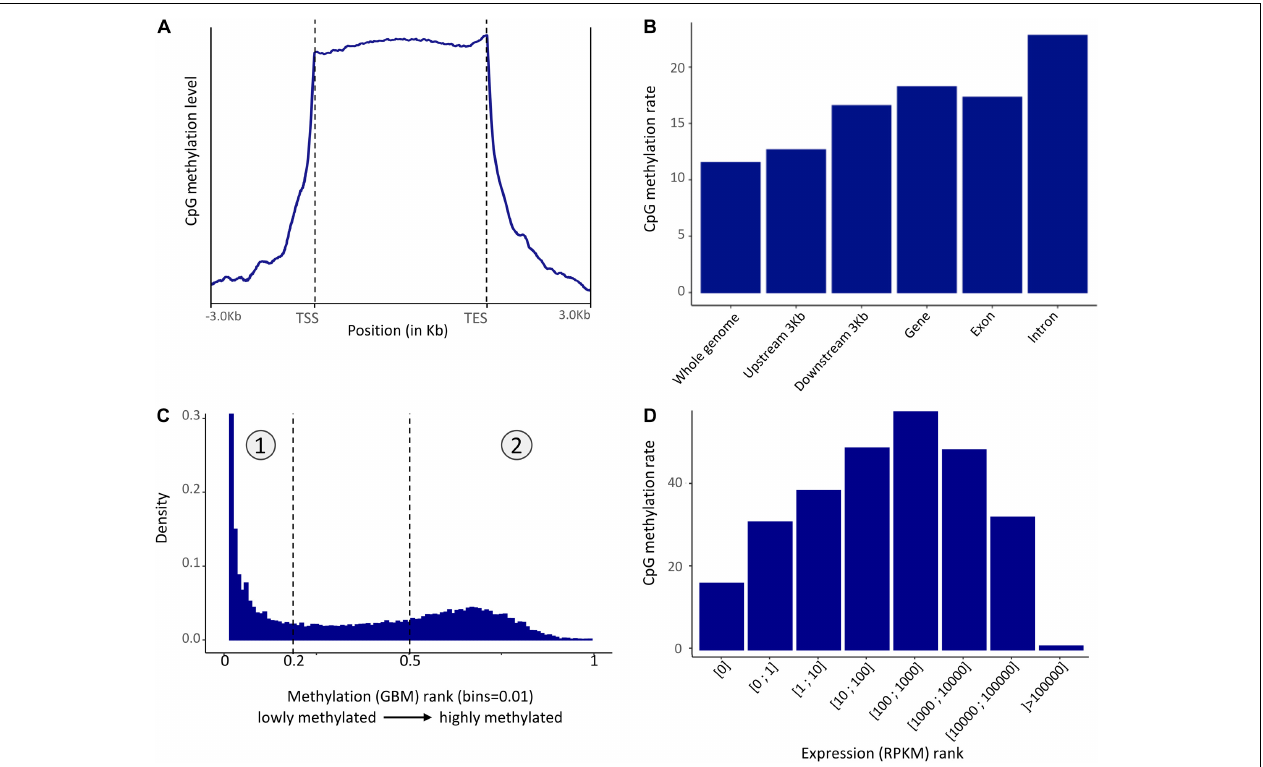
FIGURE 2 | (A) Pattern of methylation level in the mantle of P. margaritifera (TSS, Transcription Start Site; TES, Transcription End Site) reported on a metagene. (B) Distribution of methylated CpG in different genomic regions. (C) Distribution of methylated CpG across genes ranked according to methylation level. The left part (1) is composed of lowly methylated genes while the right part (2) is composed of highly methylated genes. (D) CpG methylation rate averaged across rank of gene